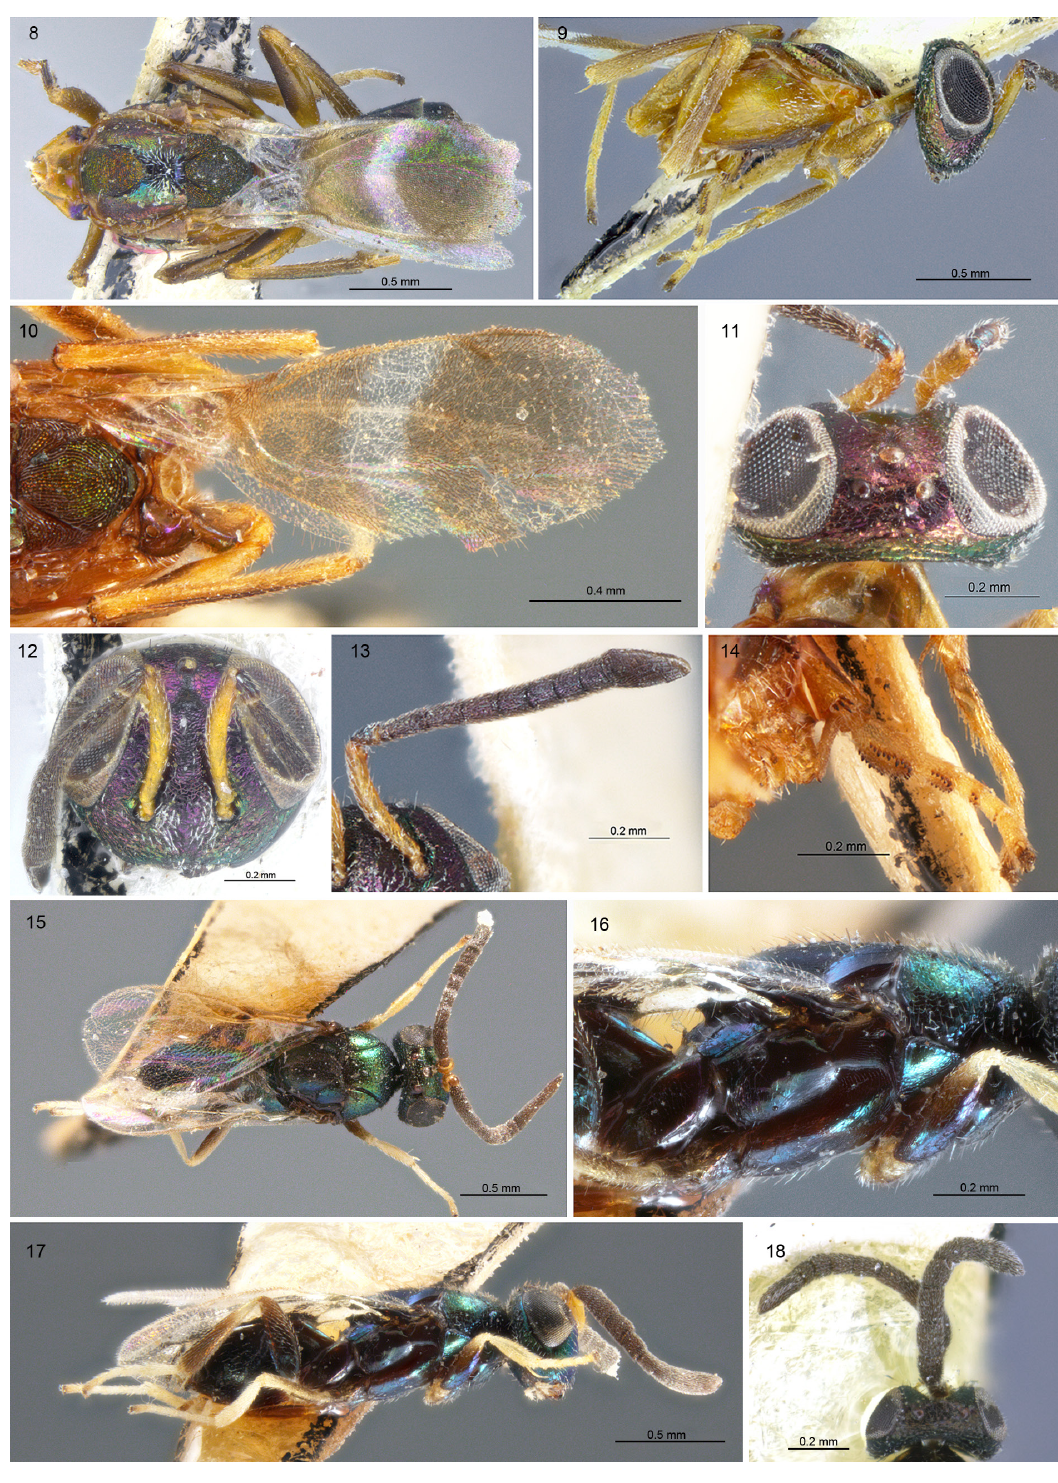
Figs 8–18. Anastatus flavipes Sheng & Wang, 1997. 8, 12–13 . Holotype, ♀. 9–11, 14 . Paratype, ♀. – 8 . Body, dorsal view. 9 . Body, lateral view. 10 . Scutellar-axillar complex and fore wing. 11 . Head, dorsal view. 12 . Head, frontal view. 13 . Antenna. 14 . Apex of mesotibia and mesotarsus. – 15–18 . Allotype, ♂. 15 . Body, dorsal view. 16 . Mesosoma, lateral view. 17 . Body, lateral view. 18 .